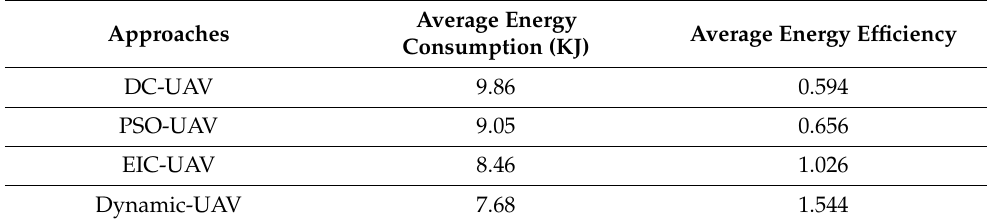
Table 7. Average energy consumption and energy efficiency